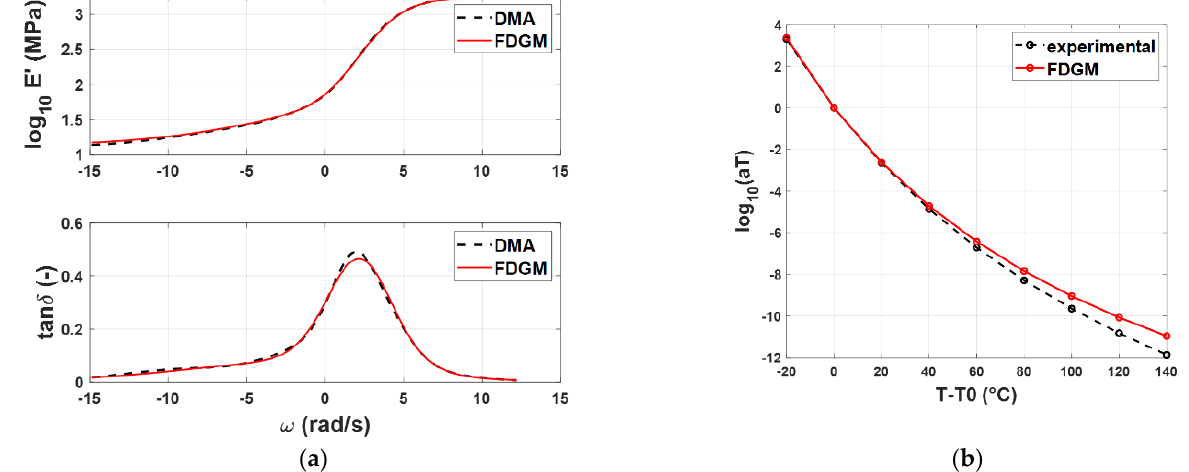
Figure 8. Compound A: Storage modulus and loss tangent ( a ), WLF law ( b ) — experimental data (dashed line) vs. FDGM model.